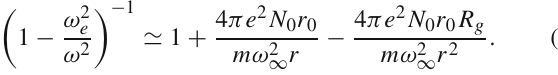
Here ω ∞ is the asymptotic value of photon frequency.